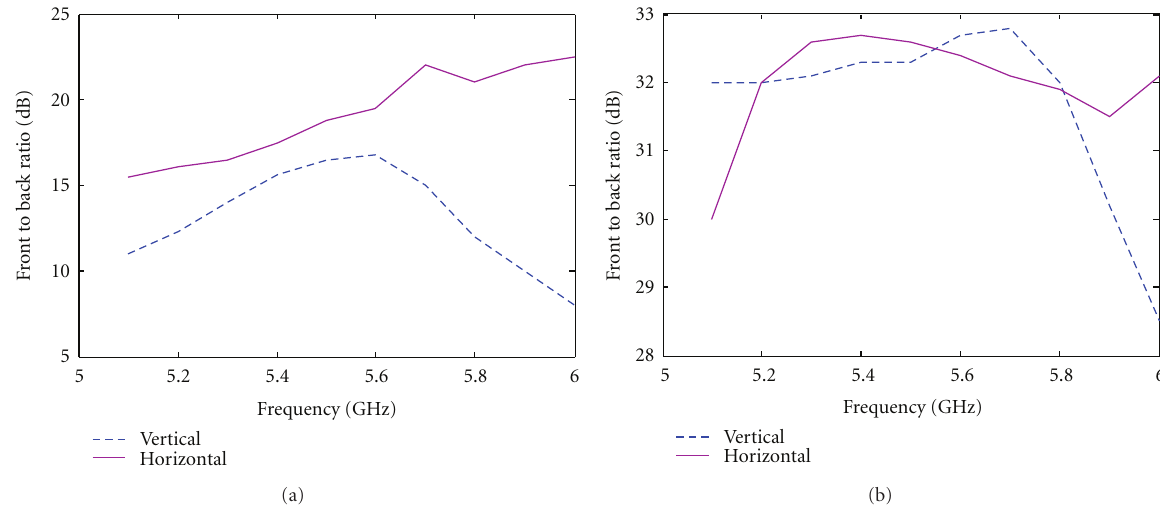
Figure 4: (a) Simulated front-to-back ratio versus frequency of 8 × 8 array antenna without plate at the back of antenna. (b) Measured front-to-back ratio versus frequency of 8 × 8 array antenna with metal plate at the back of antenna.